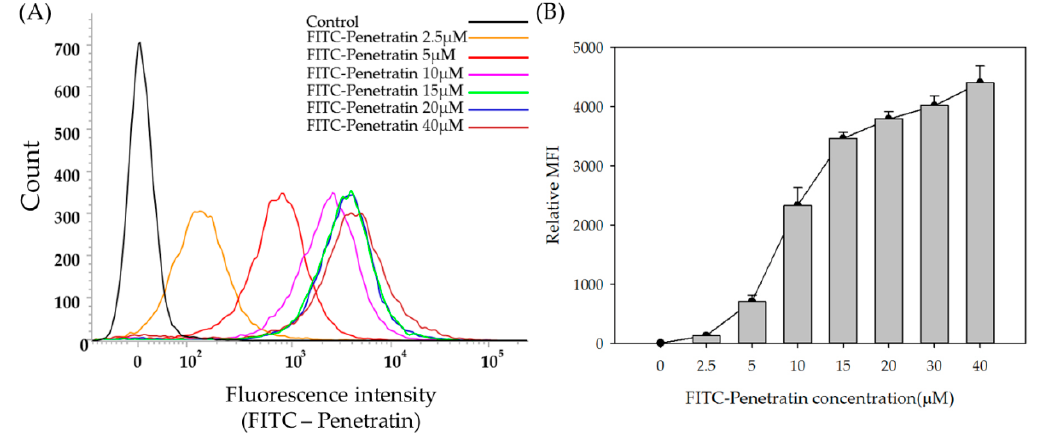
Figure 2. FACS data of FITC-Penetratin internalization in TR146 cells. Representative fluorescence intensity ( A ) and relative MFI values of FITC-Penetratin ( B ). All data were represented by mean ± S.D ( n = 3).